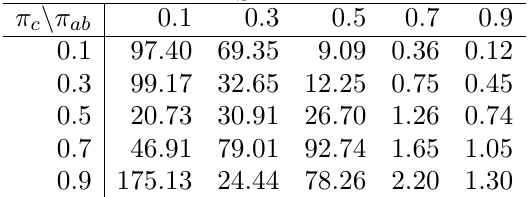
Table 1. Comparison of average out- of-sample performance.